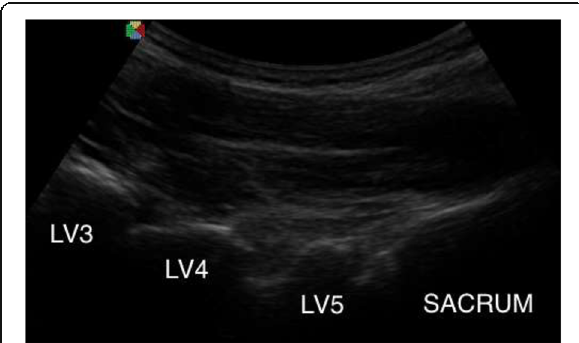
Fig. 6 Parasagittal oblique sonogram of the sacrum and laminae of lambar vertebrae